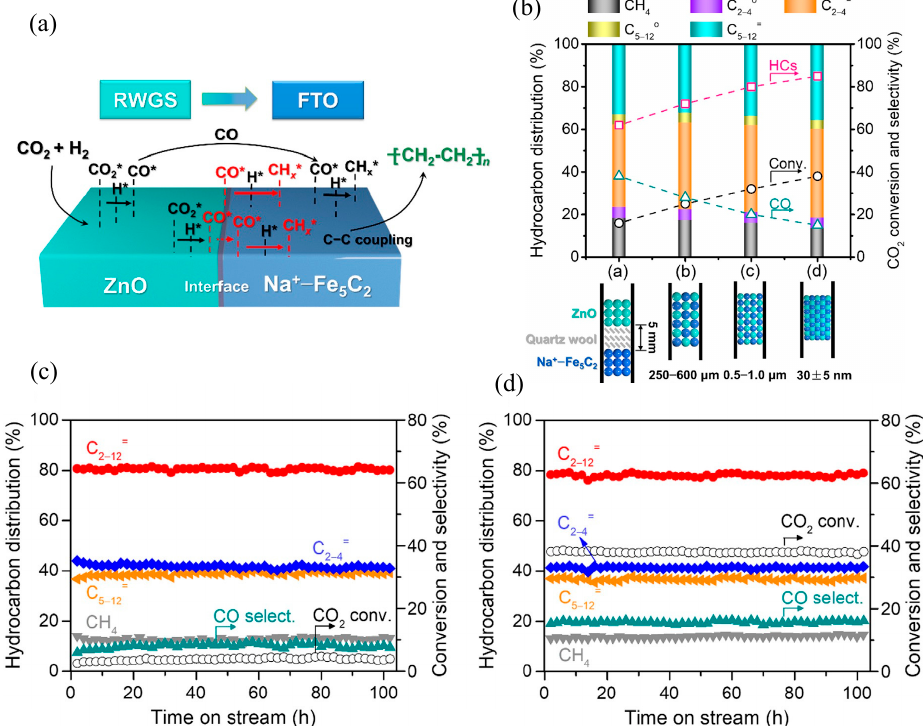
Figure 10. ( a ) Illustrated reaction mechanism for CO 2 hydrogenation over the catalyst Na-Zn-Fe. ( b ) Effect of the proximity between ZnO and Na + Fe 5 C 2 on catalytic behaviors for CO 2 hydrogenation. Catalyst stability in CO 2 hydrogenation over ( c ) an Na + Fe 5 C 2 catalyst and ( d ) a Na-Zn-Fe catalyst. Testing conditions: H 2 /CO 2 molar ratio = 3, P = 2.5 MPa, W = 0.10 g, F = 25 mL min − 1 , T = 613 K. Adapted with permission from ref. [90]. Copyright 2021 Elsevier.